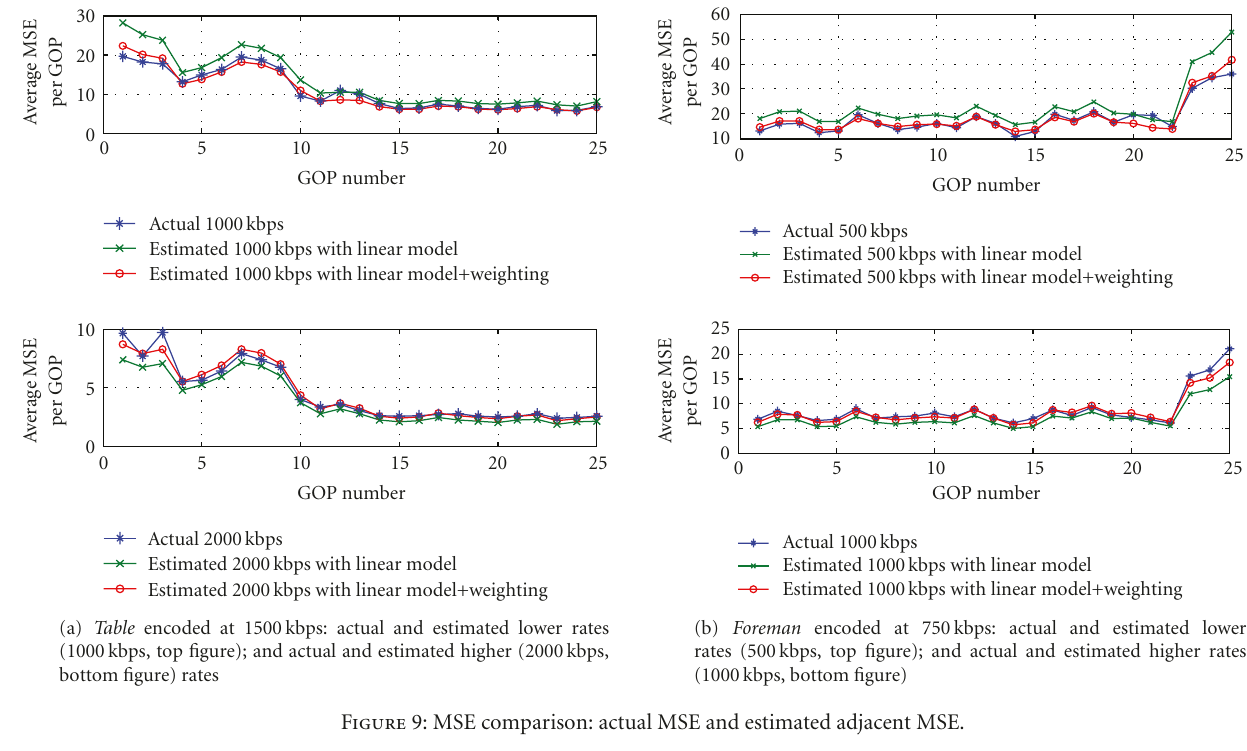
Figure 9: MSE comparison: actual MSE and estimated adjacent